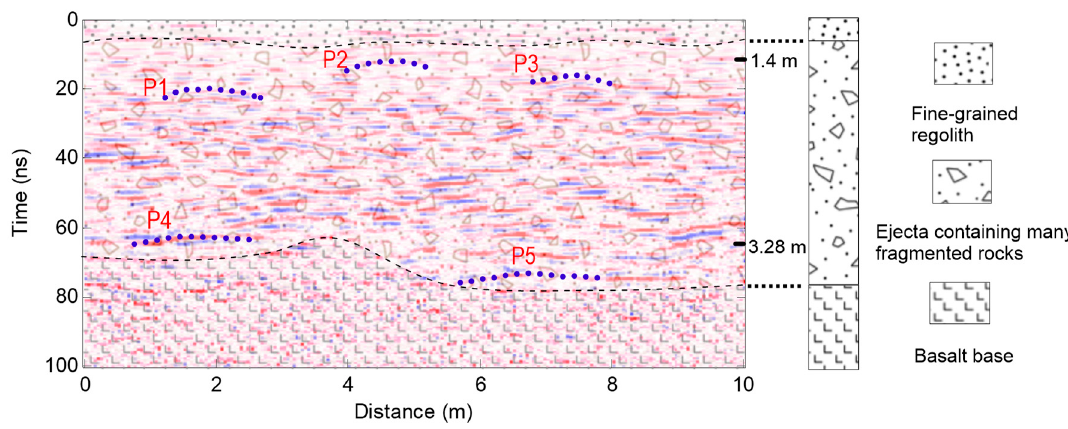
Table 1. The estimated velocities and depths of the hyperbolas